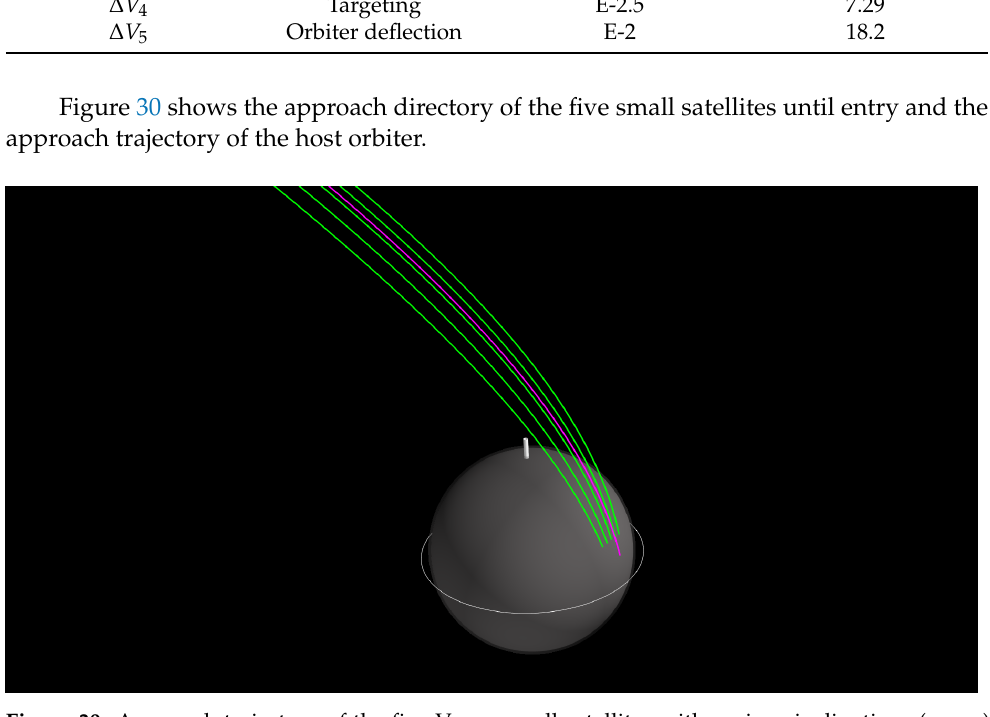
Figure 30. Approach trajectory of the five Venus small satellites with various inclinations (green) until atmospheric entry and the host orbiter (magenta) until